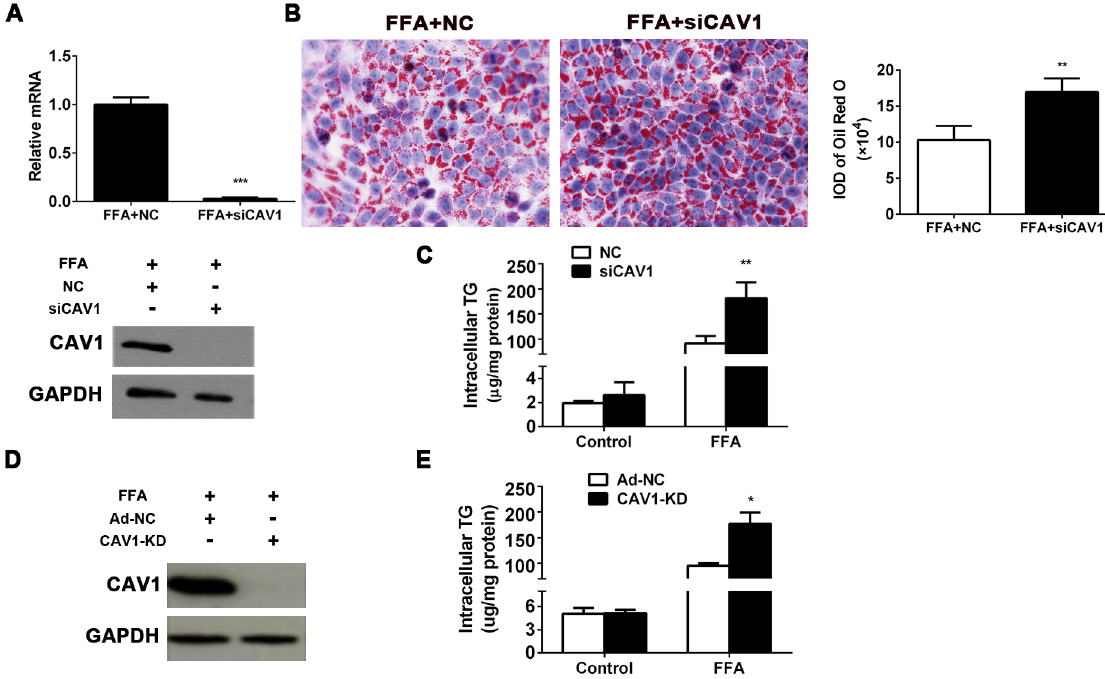
Fig 2. CAV1 depletion aggravates fat accumulation in L02 cells and AML12 cells induced by FFA. CAV1 expressionwas inhibitedusing siRNA in L02 cells and stably depletedby applyingthe CRISPR-Cas9 system by adenovirusrecombination in AML12 cells. (A-C) L02 hepatocyteswere transfected with scrambledsiRNA (NC) or siRNA targeting CAV1 (siCAV1). After transfectionfor 24 h, cells were challengedwith 1 mM FFA for another 48 h. (A) CAV1 mRNA and protein levels in FFA-treated L02 cells transfected with NC or siCAV1. (B) Representative Oil Red O stainingof FFA-inducedL02 cells with or without CAV1 siRNA transfection. (Original magnification × 400) The averageintegratedoptical density (IOD) of lipid droplets stained with Oil Red O from FFA treated cells was measuredwith an Image-Pro Plus software. (C) Triglycerides were quantified in L02 cells treated with or without FFA transfected with NC or siCAV1. (D-E) AML12 hepatocyteswere transfected with the adenovirus- CRISPR-Cas9 system to stably knockdown CAV1 (CAV1-KD); Ad-NC served as a control. Cells were challenged with 1 mM FFA for 48 h. (D) CAV1 protein levels in FFA-treated AML12 hepatocytestransfected with Ad-NC and CAV1-KD. (E) Triglycerideswere quantified from AML12 cells treated with or without FFA transfected with Ad-NC and CAV1-KD. The results are expressedas the mean ± SD of 3 independentexperiments. ( * P < 0.05, ** P < 0.01, and *** P <